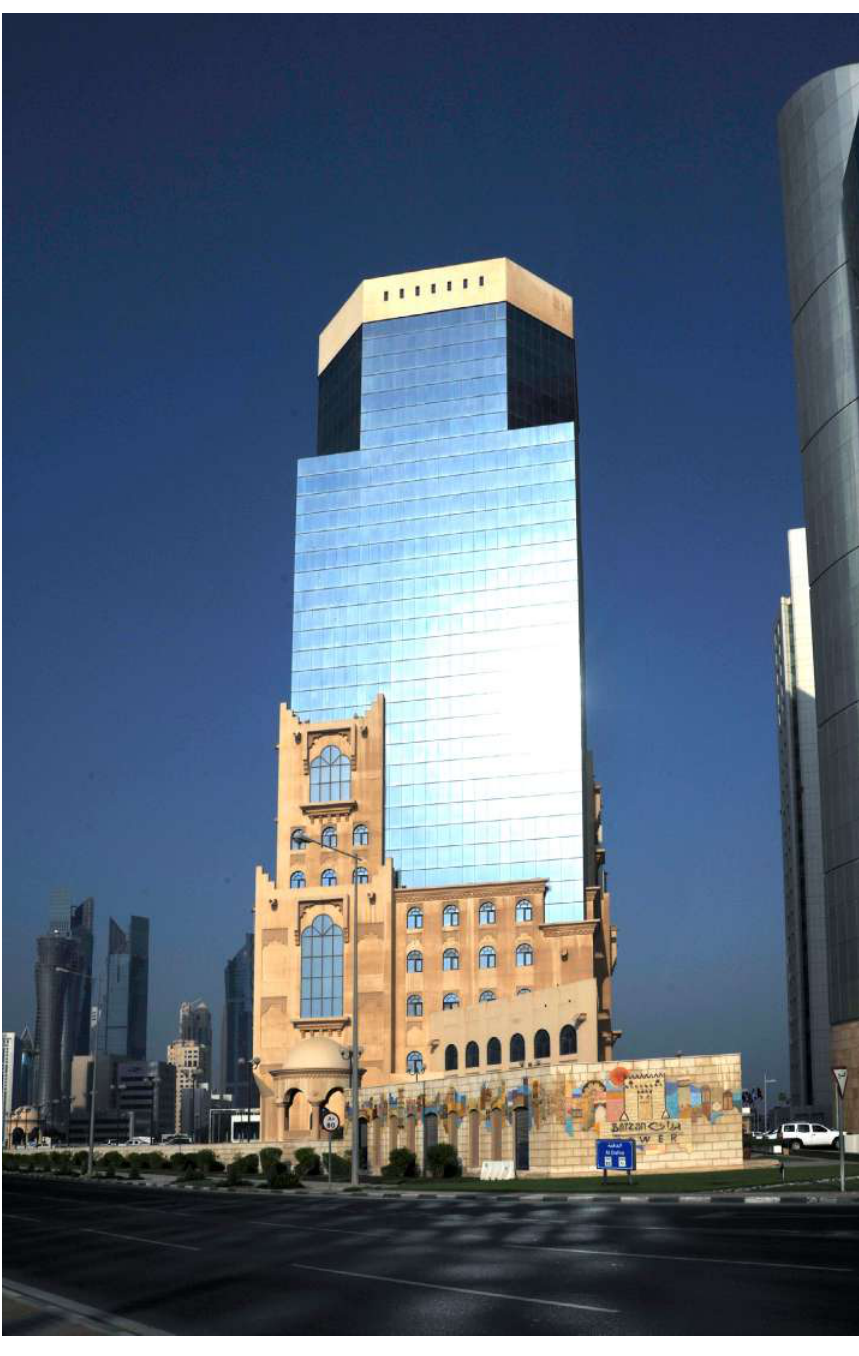
Barzan Tower hosting the Min - istry of Labour offices (Source: Peter Chomowicz,